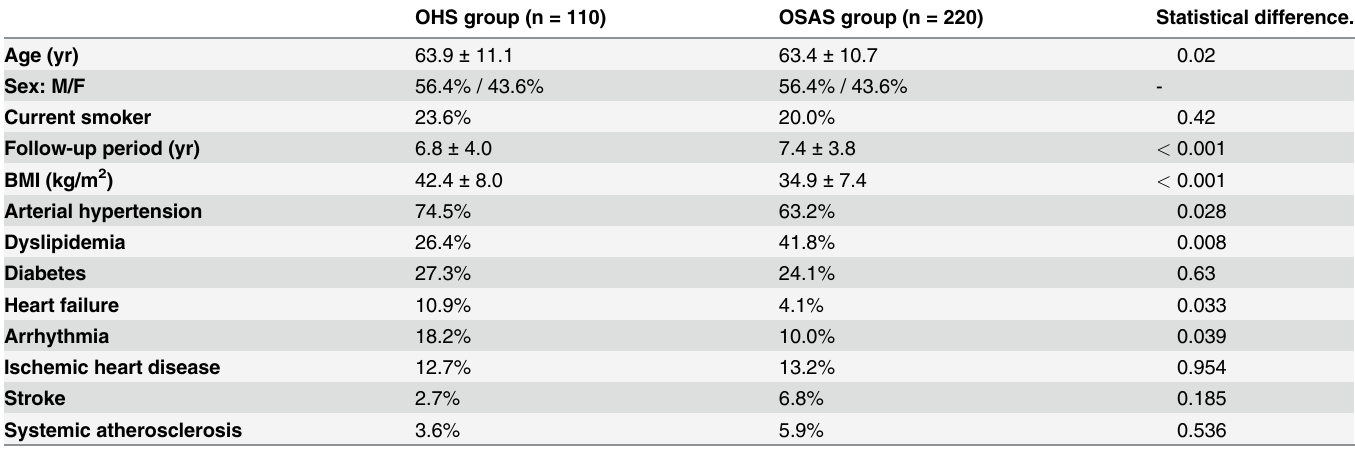
Table 1. Demographic characteristics, cardiovascular risk factors and history of cardiovascular disease of the 2 cohorts. OHS group (n = 110) OSAS group (n = 220) Statistical difference.